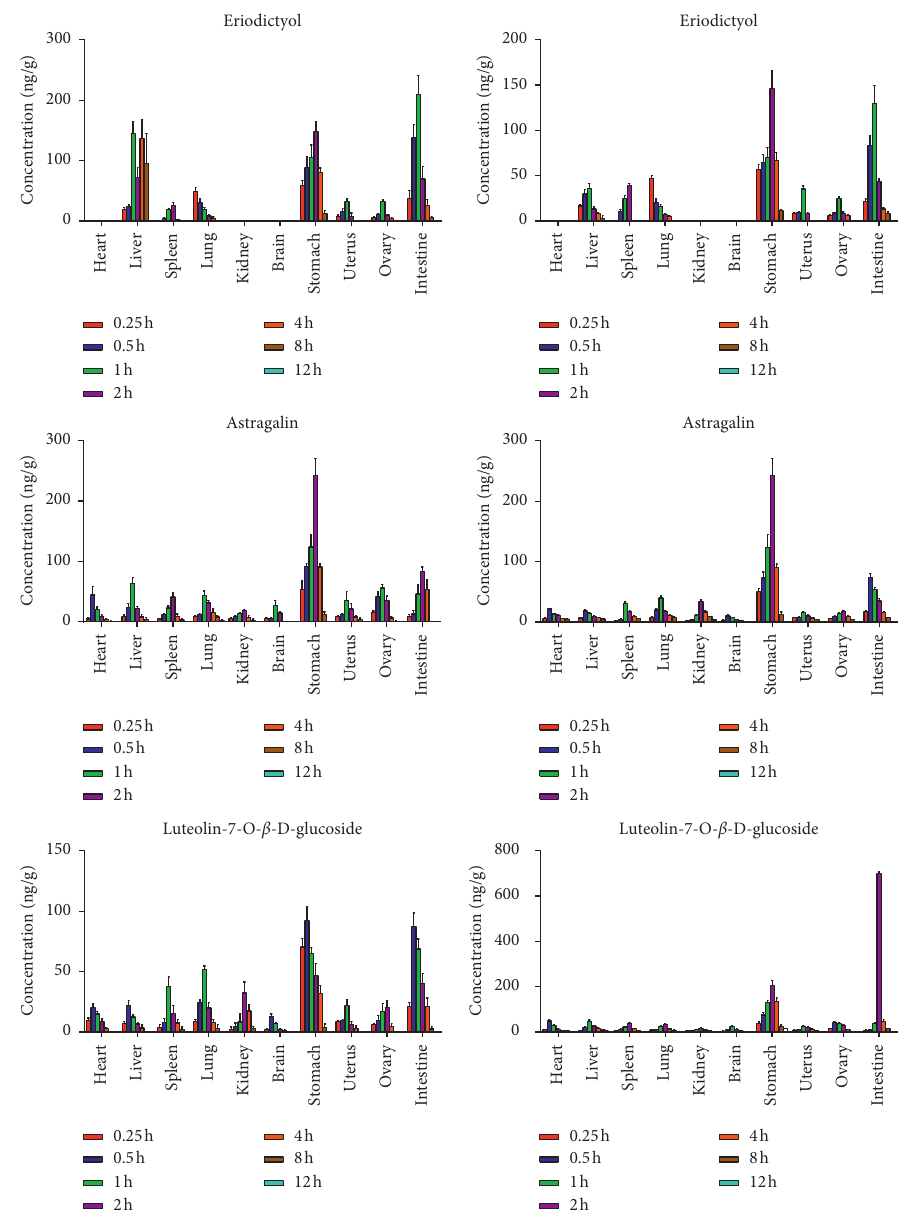
Figure 3: Concentrations of seven analytes in rat tissues at 0.25, 0.5, 1, 2, 4, 8, and 12h after oral administration of TFDR in 8-month-old rats (left) and 18-month-old rats